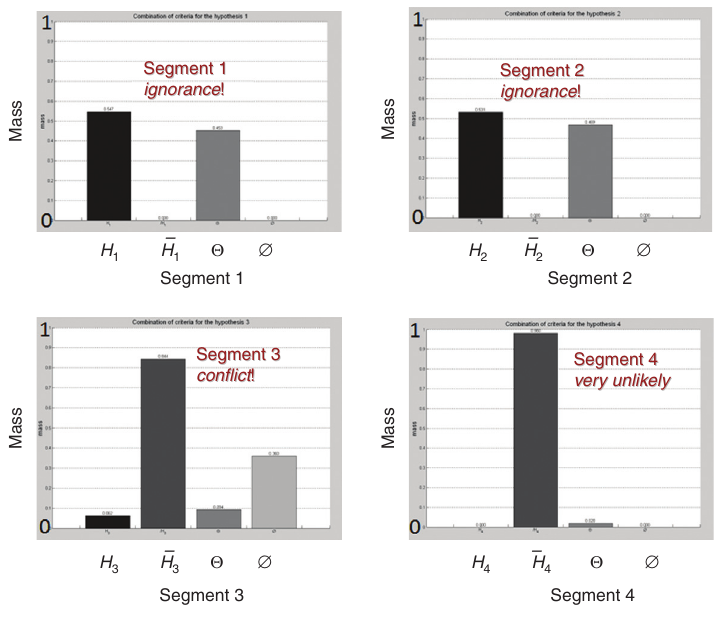
and c for Hypothesis j = 1, …, 4. 1 2